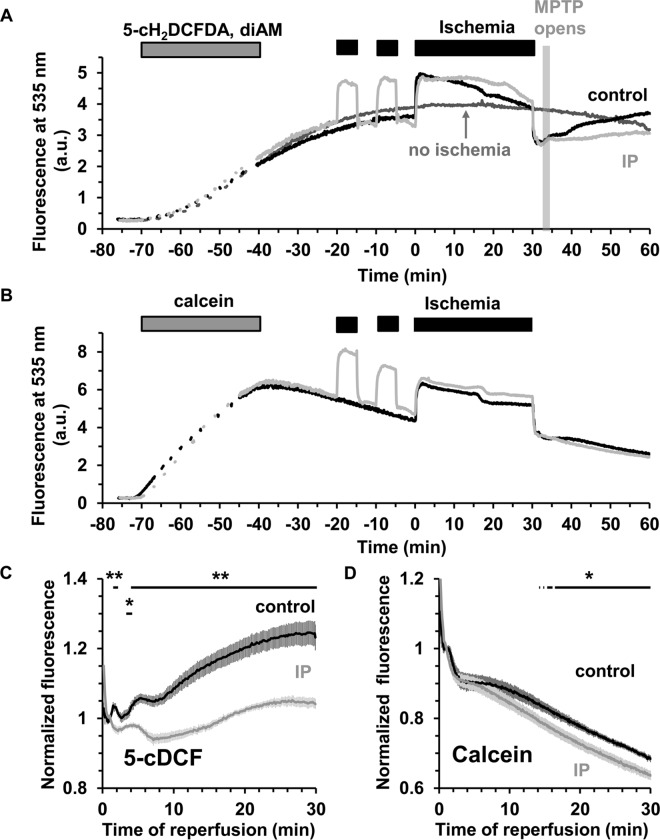
ROS measurements using 5-cDCF surface fluorescence in control and IP hearts during ischemia / reperfusion A, Typical traces for 5-cH2DCFDA, diAM loaded control and IP hearts. B, Parallel data for hearts loaded with the ROS-insensitive dye, calcein-AM. The signal from a non-ischemic 5-cH2DCFDA, diAM loaded heart (A, dark grey trace) demonstrates good dye retention during the time of the experiment. C and D, Mean data (± SEM, error bars) of 6 hearts loaded with 5-cH2DCFDA, diAM (C) or calcein-AM (D). Signals were normalized using the mean fluorescence value obtained after 1 min of reperfusion. Note that loss of calcein signal with time is due to dye leakage and occurs even in normoxia. Statistically significant effects of IP are shown by the horizontal lines (** p ≤ 0.01; * p ≤ 0.05). Corresponding infarct sizes are presented in Table 1.